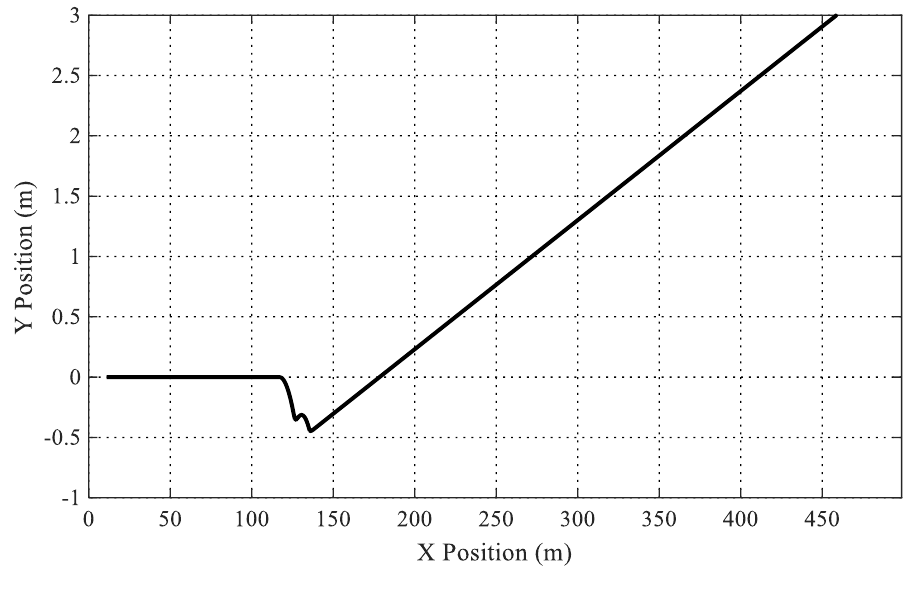
Figure 19. Position of the Vehicle for Scenario 2 and